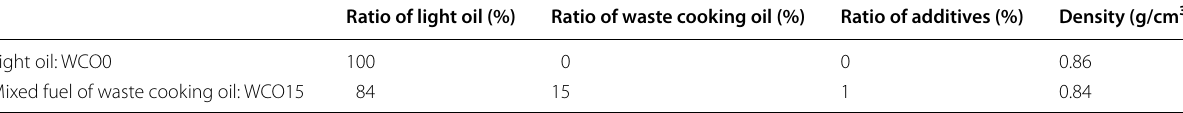
Table 3 Mixture of diesel fuel ratio of